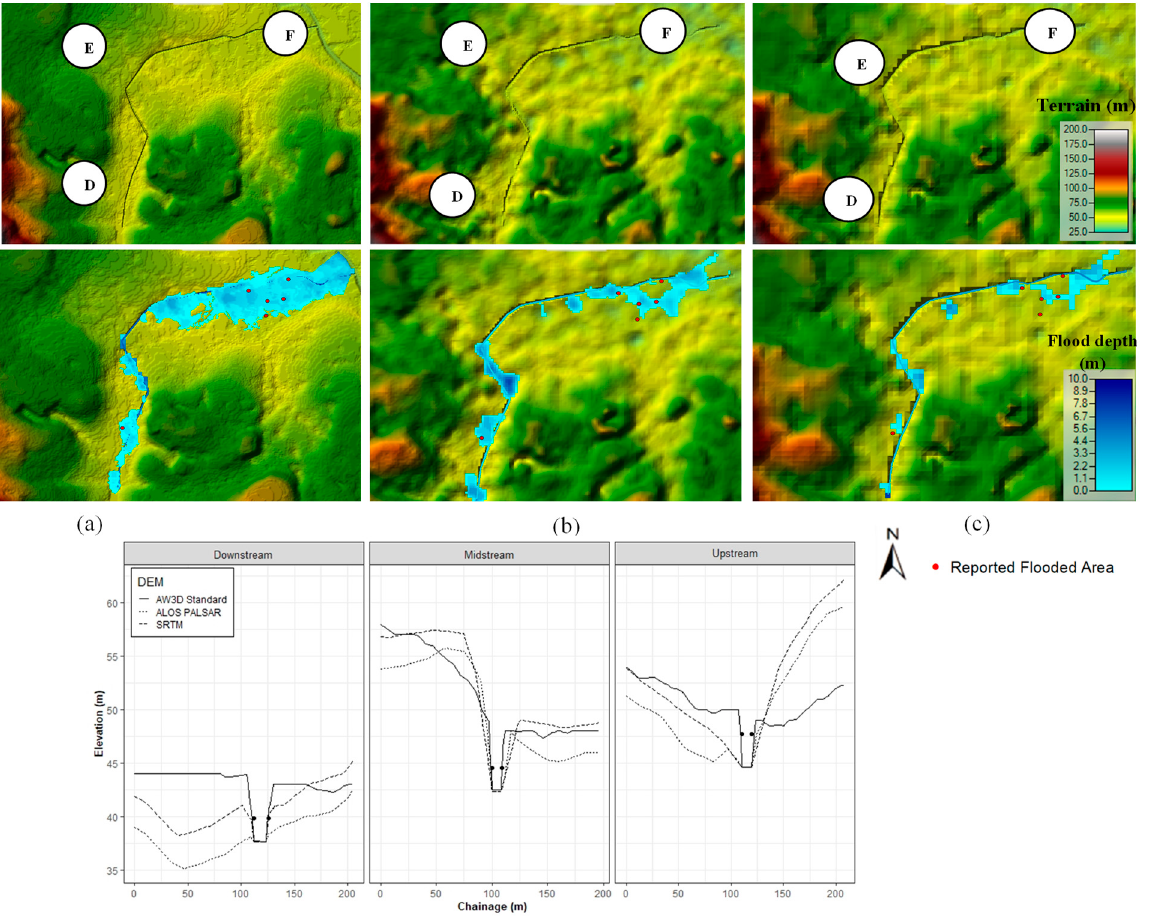
Figure 6. River cross-sections at three different locations: D = upstream, E = midstream and F = downstream. Black dots in the cross-sections are referring to the riverbank. Flood maps of simulated flooded area and depths from 100-year return period event for ( a ) AW3D Standard ( b ) ALOS PALSAR and ( c ) SRTM. Reported flooded locations are in red dots.